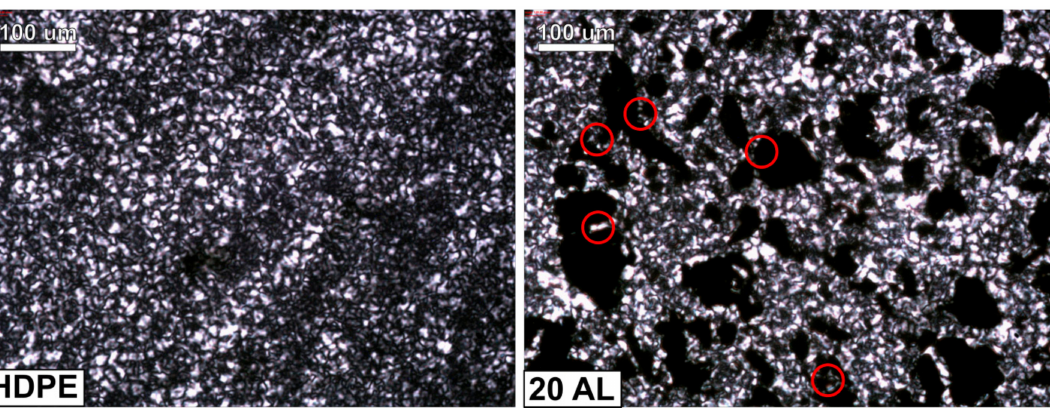
Figure 14. The crystalline structure of the PE ( left ) and PE / 20Al composite ( right ), the red circles mark the areas where the crystallites are less developed because of spatial hindrances cause by presence of Al